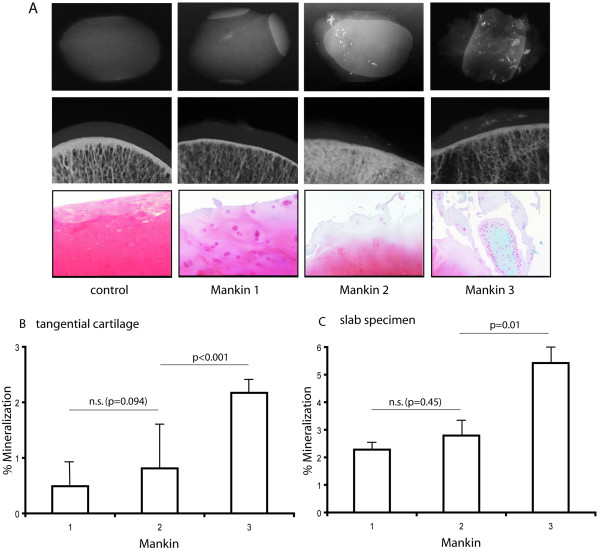
Cartilage mineralization and correlation with the degree of histologic changes. Histological assessment was performed on tangential cut cartilage using a modified Mankin scoring system. Three representative histological sections from each Mankin grade and one from the control group are shown with their corresponding DCRs. Whereas the 10 controls show intact articular cartilage with no mineralization detected, an increase in matrix mineralization with further cartilage destruction was observed by DCR (A). A statistically significant positive correlation between OA grade and articular cartilage mineralization for both the slab specimens and the tangential cut articular cartilage was observed in specimens graded as Mankin II and III (I-II: p = 0.036; II-III: p = 0.001) (B, C).